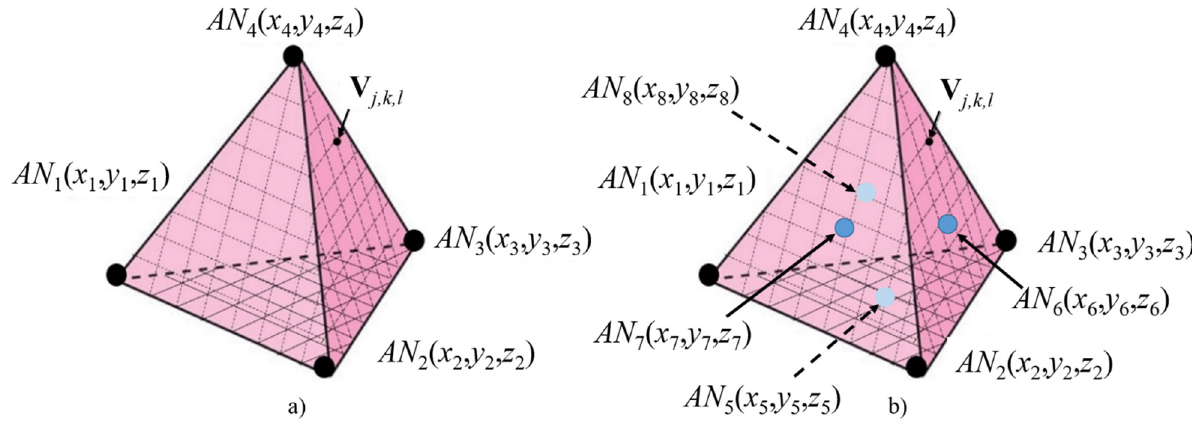
Figure 5. The 3D Scenario for ( a ) four available ANs and ( b ) up to eight available ANs.